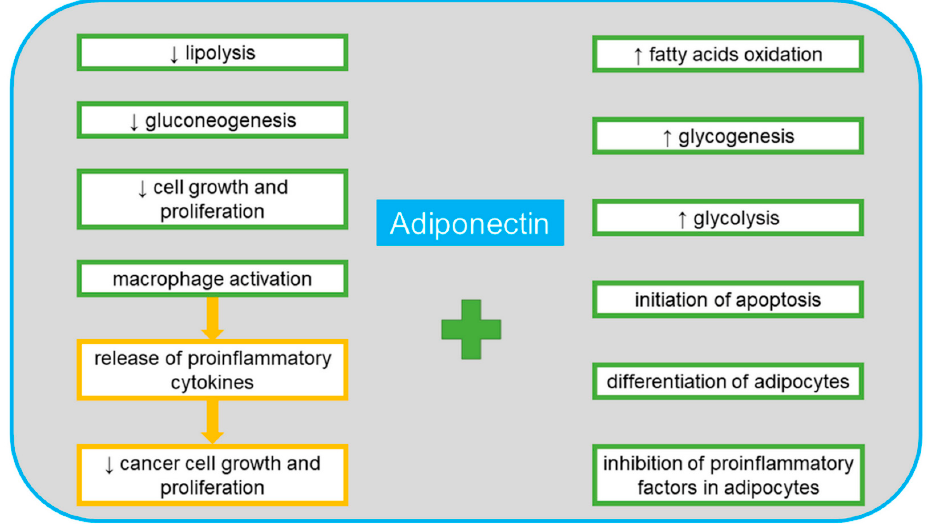
Figure 2. The positive systemic effects of adiponectin.